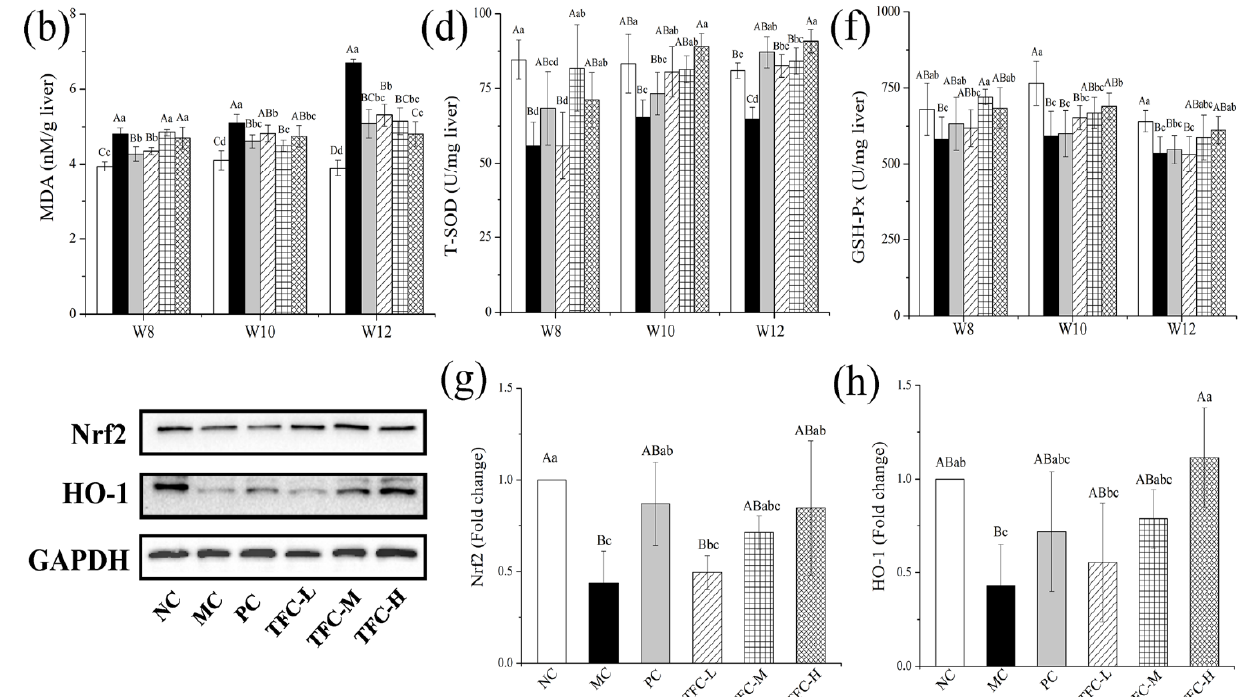
Figure 6. Effects of TFC on oxidative stress in NAFLD mice: ( a ) serum MDA, ( b ) liver MDA, ( c ) serum T-SOD, ( d ) liver T-SOD, ( e ) serum GSH-Px, and ( f ) liver GSH-Px. The protein expression of ( g ) Nrf2 and ( h ) HO-1 in the liver in the twelfth week was detected by Western blotting. Different letters indicate significant differences; abcd p < 0.05, and ABCD p < 0.01.